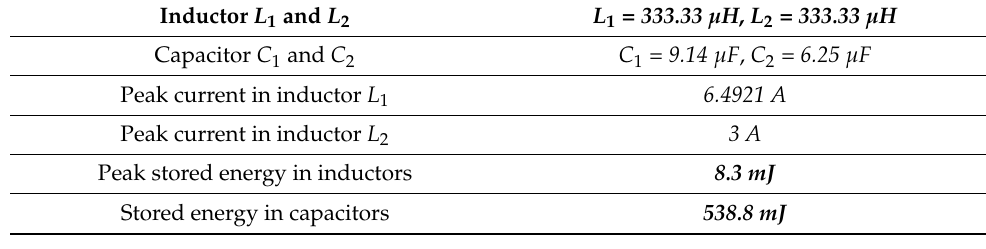
Table 4. Cuk converter results.